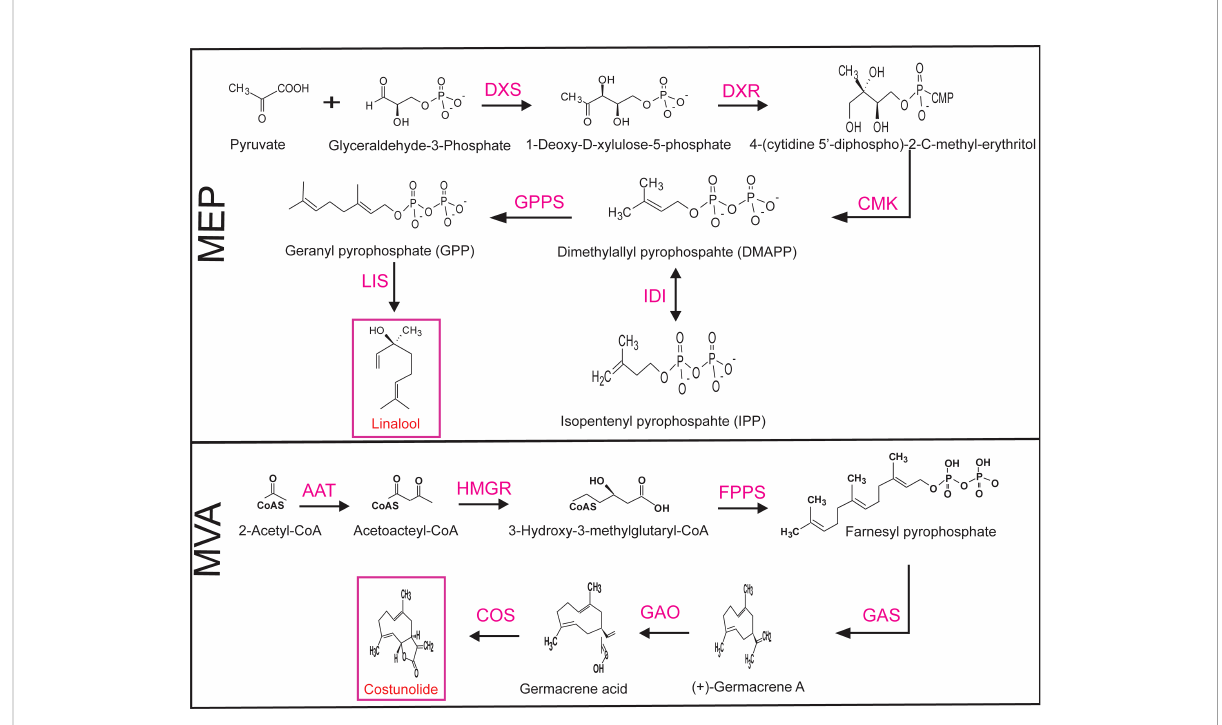
FIGURE 1 Simpli fi ed selected biosynthetic pathway genes of the MEP and MVA pathways. Pink indicates the genes selected in this study. MEP, plastid 2-C- methyl-D-erythritol 4-phosphate; MVA, mevalonate; DXS, 1-deoxy-D-xylulose-5-phosphate synthase; DXR, 1-deoxy-D-xylulose 5-phosphate reductoisomerase; CMK, 4-diphosphocytidyl-2-C-methyl-D-erythritol kinase; IDI, isopentenyl-diphosphate isomerase; GPPS, geranyl pyrophosphate synthase; LIS, linalool synthase; AAT, acetoacetyl-CoA thiolase; HMGR, 3-hydroxy-3-methylglutaryl-CoA reductase; FPS, farnesyl pyrophosphate synthase; GAO, germacrene A oxidase; GAS, germacrene A synthase; COS costunolide